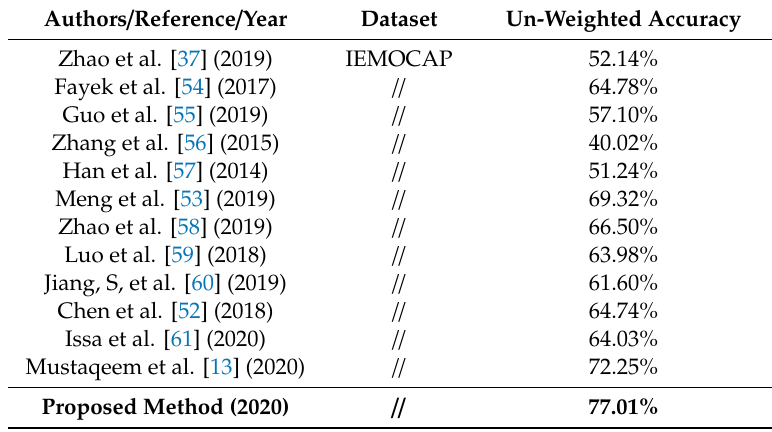
Table 8. Comparative analysis of the suggested SER system and the baseline SER system using the IEMOCAP and the EMO-DB speech